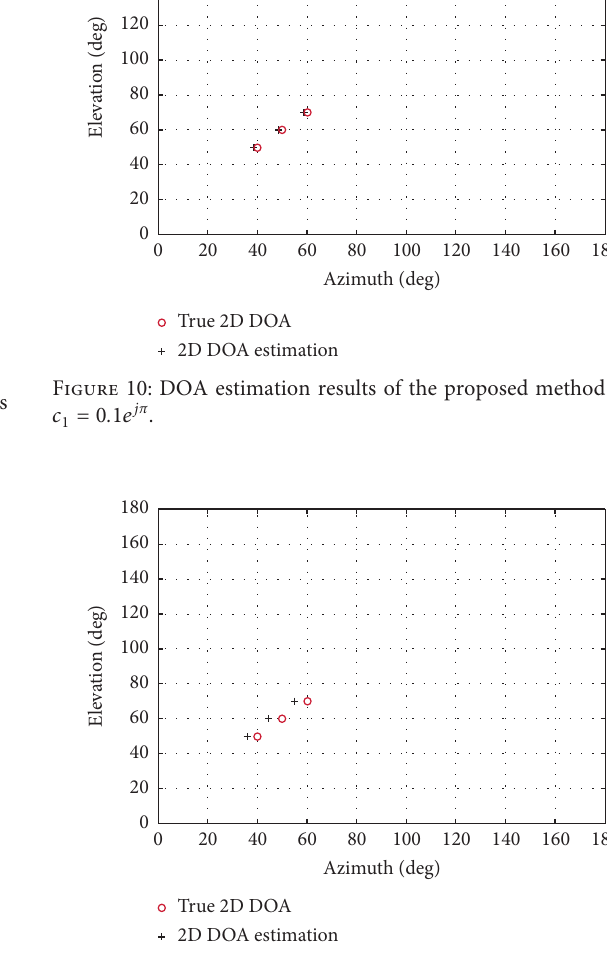
Figure 11: DOA estimation results of PM [9] with c